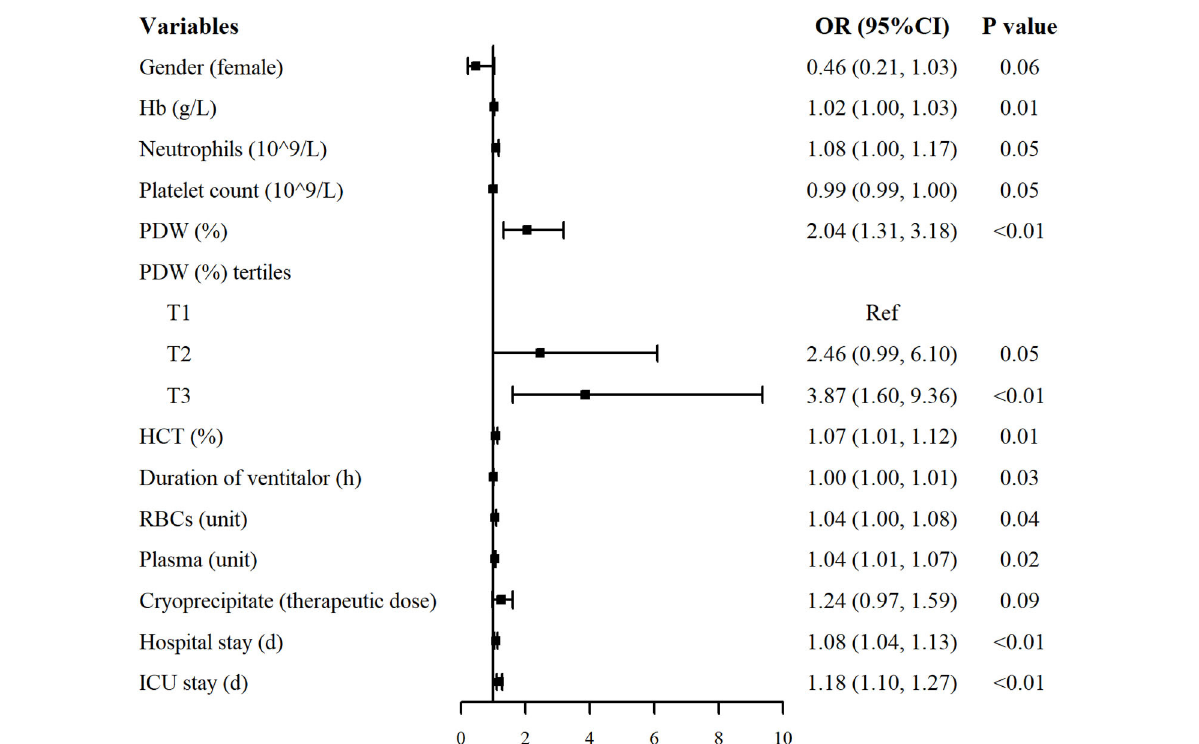
FIGURE2 Univariate analysis for postoperative pneumonia in patients with AAAD. Only variables associated with postoperative pneumonia were listed ( P < 0.10). OR, odds ratio; CI, confidence